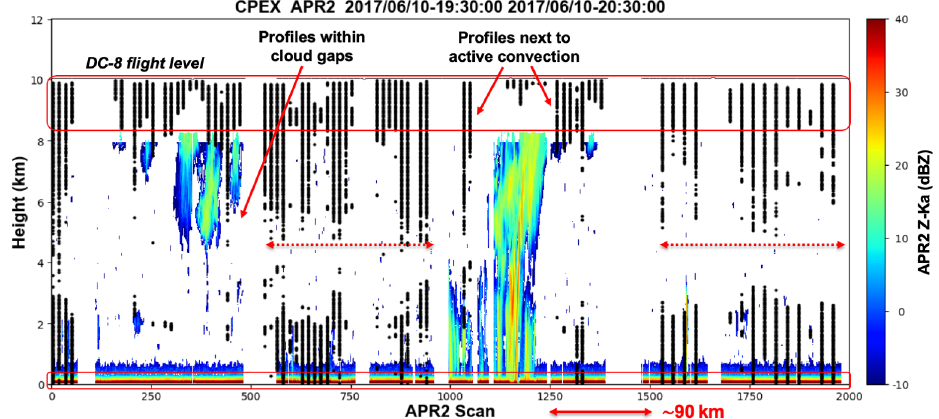
Figure 12. Cross section of the APR-2 Ka-band reflectivity (color scale to right) during segment 2 (19:30–20:30UTC). Same layout and format as Fig. 8.